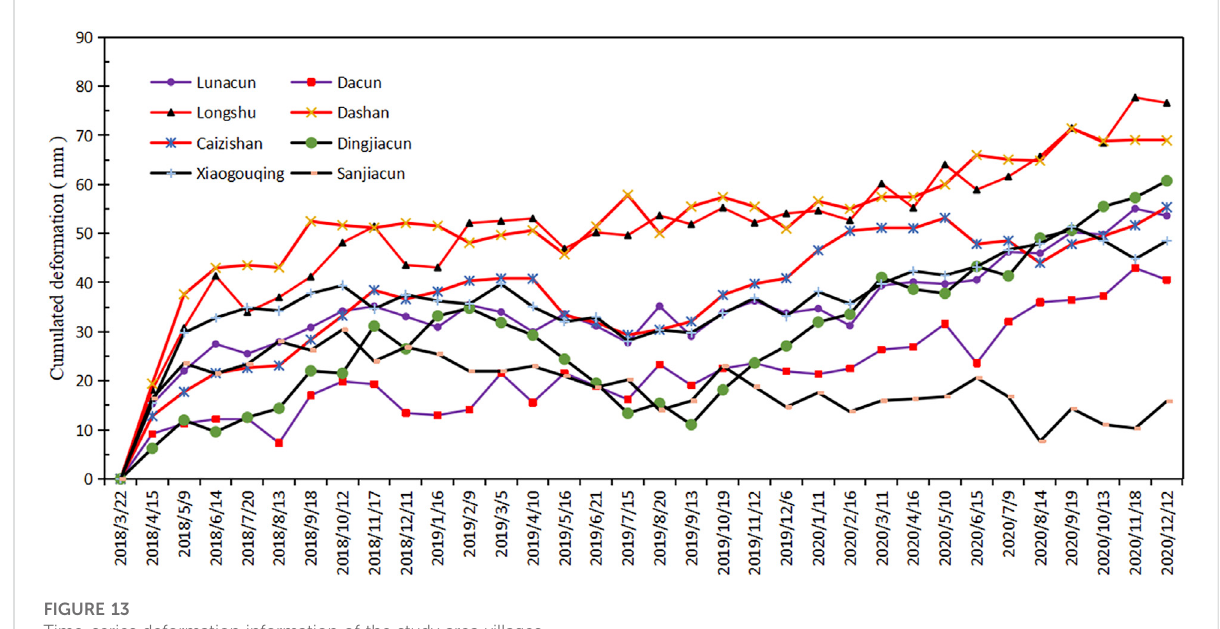
FIGURE 13 Time-series deformation information of the study area villages.